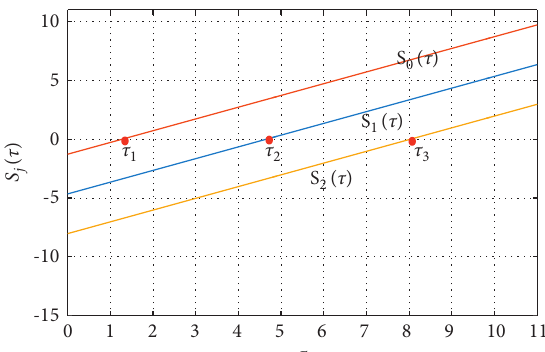
Figure 7: Graph of S ( τ ) versus τ for the neuron model (4) with delay-independent parameters. j